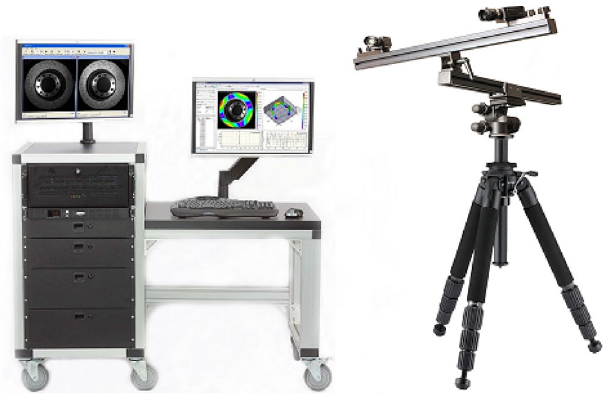
Figure 11. The vic-3D imaging